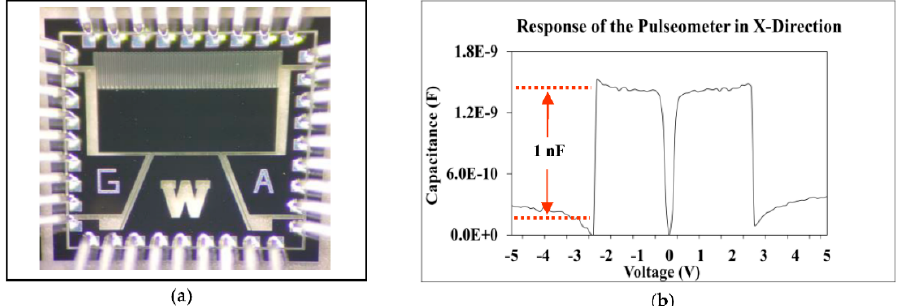
Figure 4. ( a ) Fabricated pulsometer connected to probe card and ( b ) capacitive response of the pulsometer from − 5 V to 5